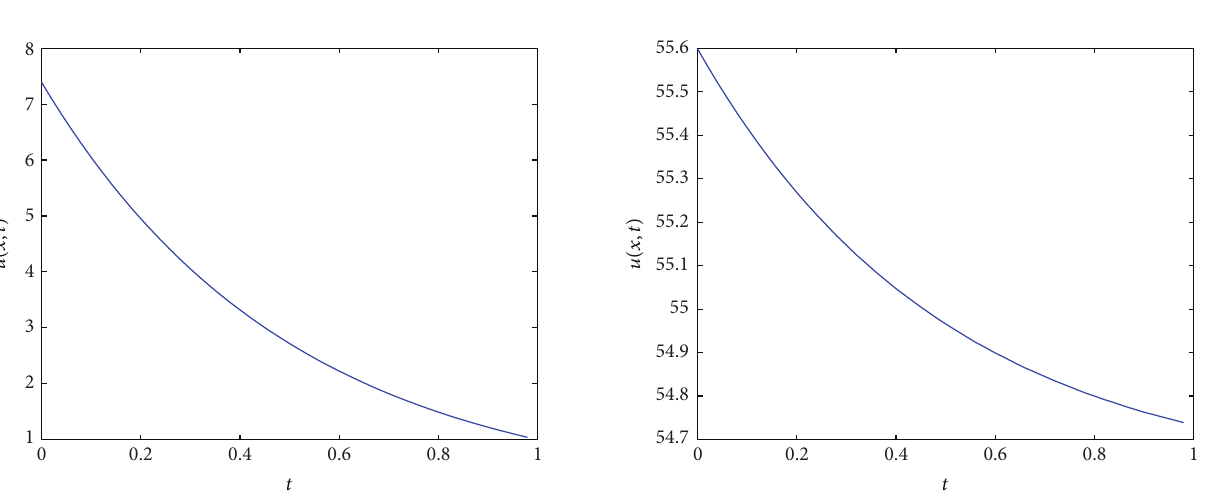
Figure 3: Plot of 𝑢(𝑥,𝑡) with respect to 𝑡 , 𝑡 ∈ [0, 1] at 𝑥 = 2 for Examples 1 and 3.